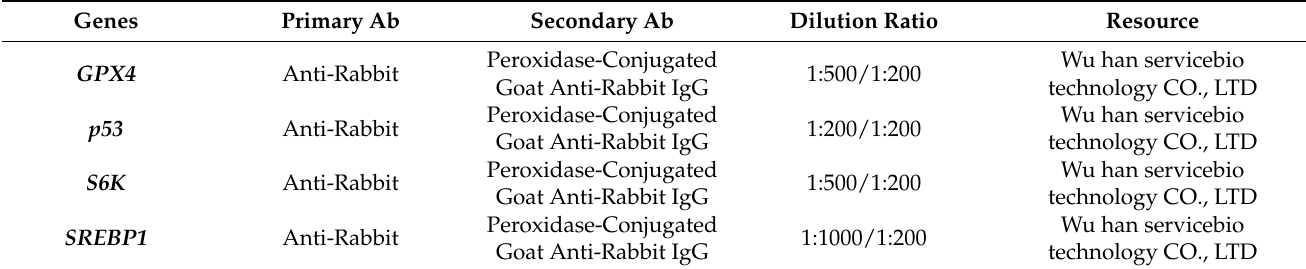
Table 3. Antibody information for immunohistochemistry.